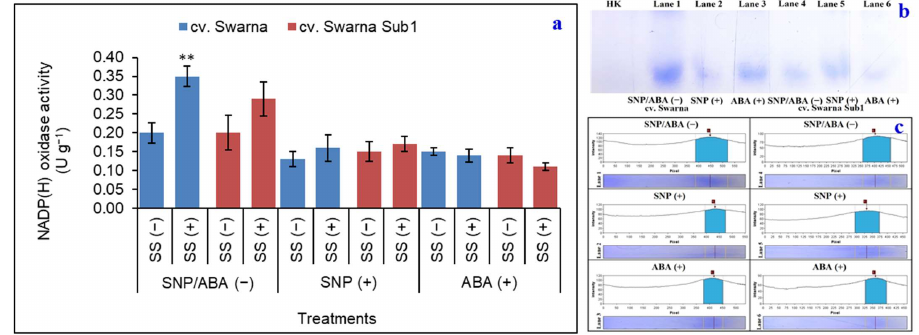
Figure 7. Changes in NADP(H) oxidase activity ( a ) and its polymorphic expression profile and densitometric analysis (( b ) and ( c ), respectively) in two rice genotypes (cv. Swarna and Swarna Sub1) under salinity stress [SS (+)] and non-salinity stress [SS (−)] for 72 h with [SNP (+) or ABA (+)] or without [SNP/ABA (−)] priming for 24 h. Data are presented in bars with mean ± SE ( n = 3) from independent experimental sets and the significant values are represented as * ( p ≤ 0.05), ** ( p ≤ 0.01) and *** ( p ≤ 0.001) by student’s t -test to denote the significant difference between SS (−) and SS (+) of SNP/ABA (−) as well as SNP (+) and ABA (+) of each rice genotype. Loading plot: HK-heat killed.